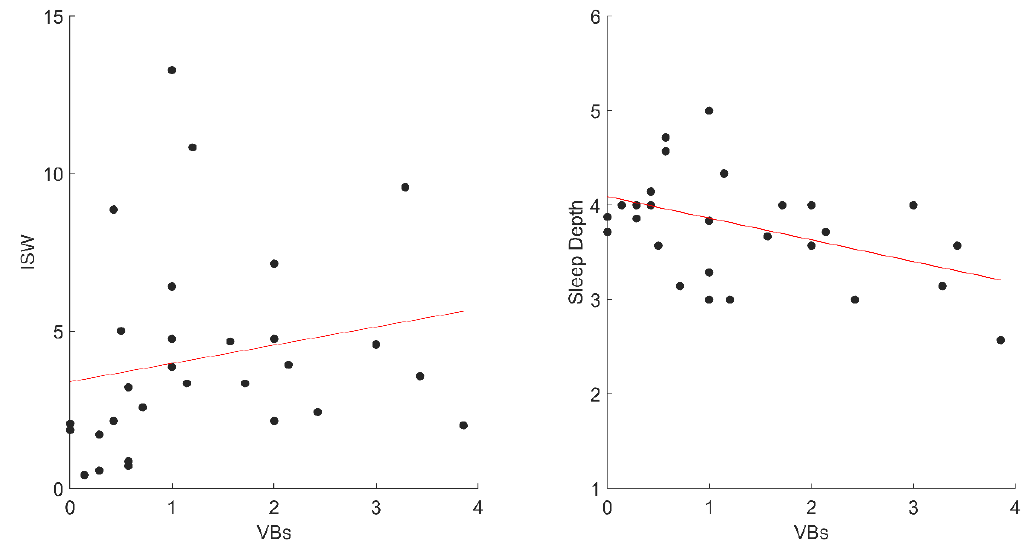
Figure 2. The significant correlations between VBs and sleep diaries variables in STs. Abbreviation: VBs, ST Verbal; ISW, Intra-Sleep Wakefulness.